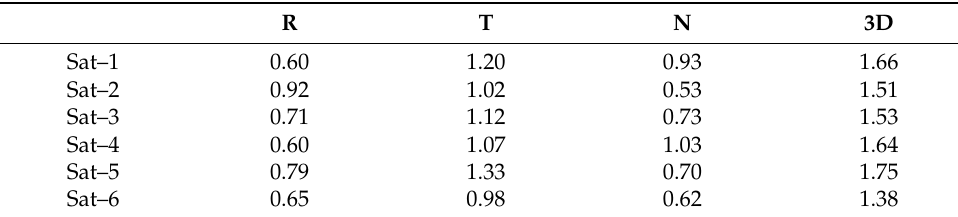
Figure 8. RMS of differences between overlapping orbits for COSMIC-2. Table 6. Mean RMS of differences between overlapping orbits for COSMIC-2 (cm).